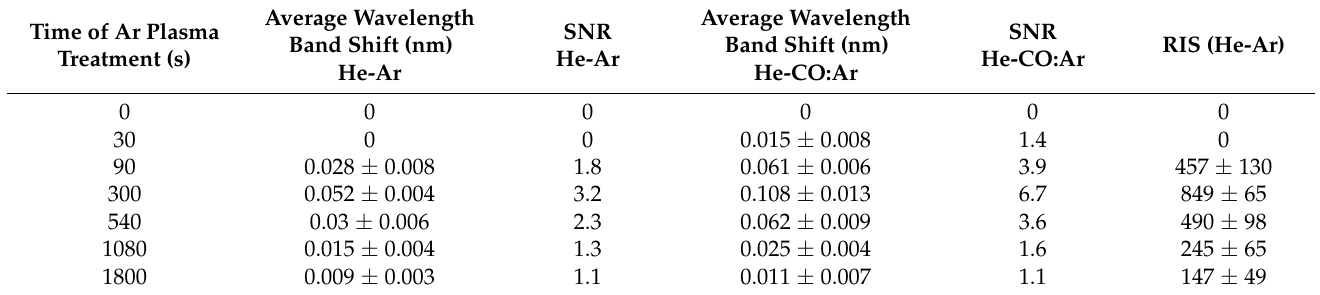
Table 2. Optical response parameters of the He-Ar and He-CO:Ar tests as a function of Ar plasma treatment